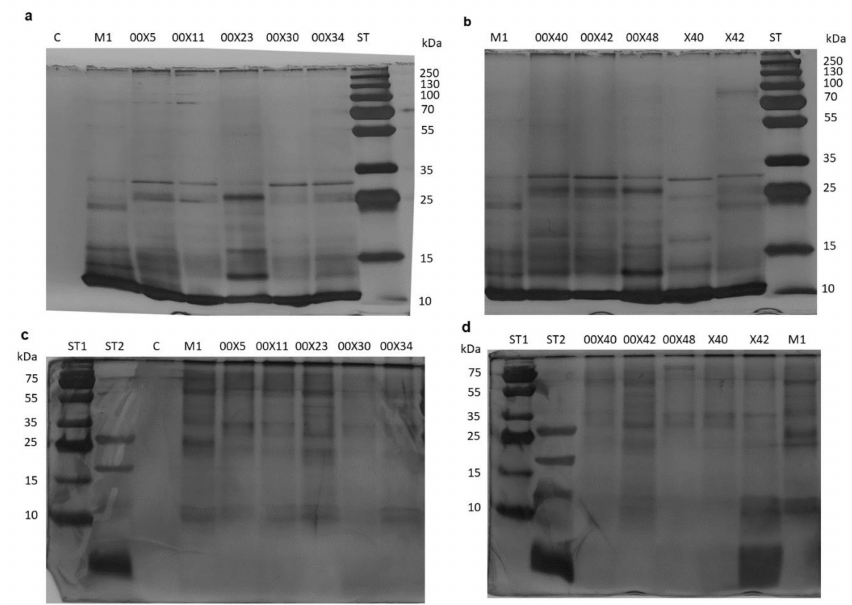
Figure 3. Electrophoretic separation of proteins secreted into the medium by Pythium strains. The proteins were separated by 15% SDS-PAGE ( a , b ) and 16% Tricine-SDS-PAGE ( c , d ). ST1-Thermo Scientific PageRuler Plus Prestained Protein Ladder (kDa): 250; 130; 100; 70; 55; 35; 25; 15; 10. ST2-Polypeptide SDS-PAGE Bio-Rad (kDa): 26.6; 17; 14.4; 6.5; 3.5; 1.4. Each code (00X5, 00X11, 00X23, 00X30, 00X34, 00X40, 00X42, 00X48, X42, and M1) represents rapeseed plants treated with a Pythium strain. Control (C) was prepared as untreated rapeseed plants.